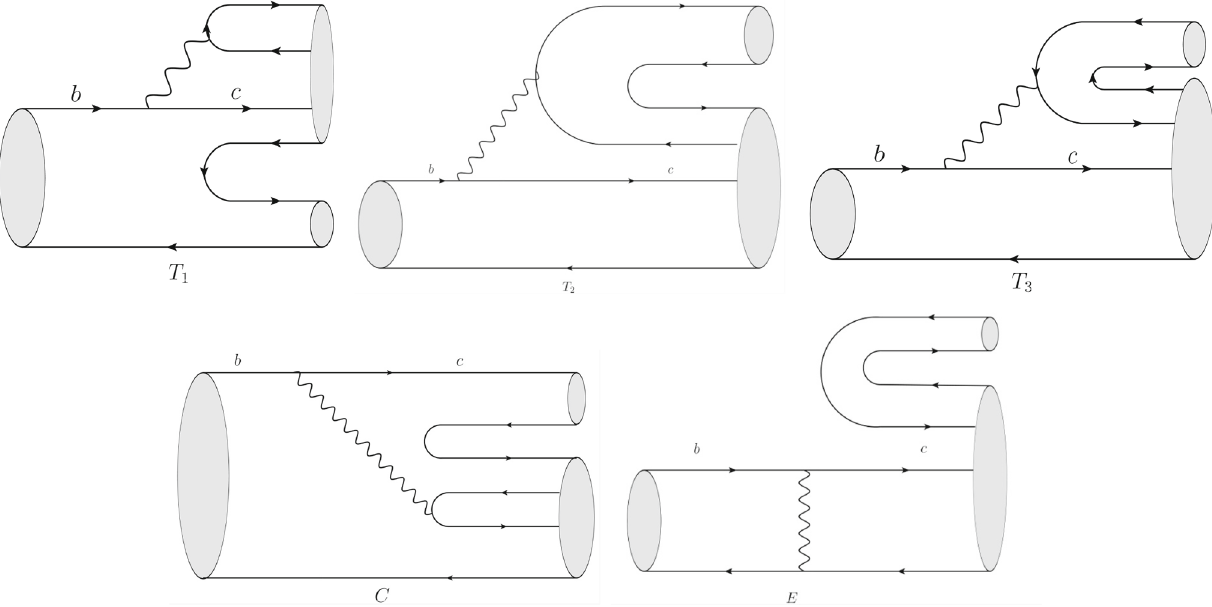
Fig. 1 Topological diagrams that contribute to the B meson decays into a tetraquark and a meson. The wavy lines indicate the W boson exchanged in the four-quark vertices. All possible gluon exchanges between the quark lines are in principle included but omitted in the